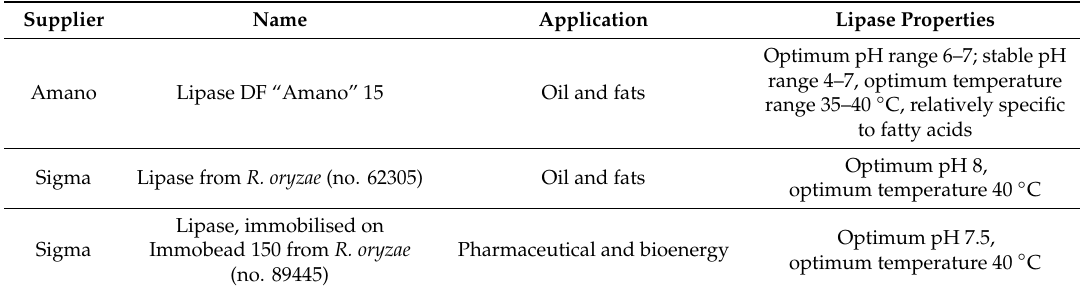
Table 1. Major commercial suppliers of Rhizopus oryzae lipase and some lipase properties [16].